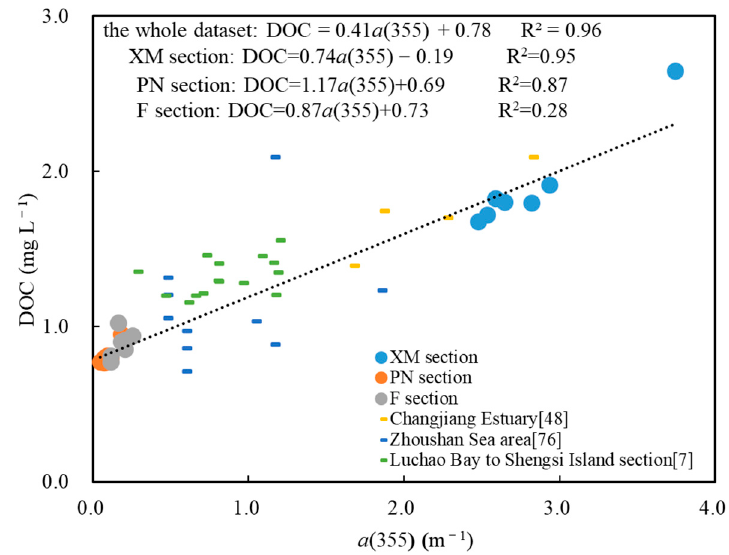
Figure 10. The correlations between the a ( 355 ) and dissolved organic carbon (DOC) in the three sections sampled in this study. The datasets from previous studies [7,48,76] are distributed evenly along the regression line for this study.